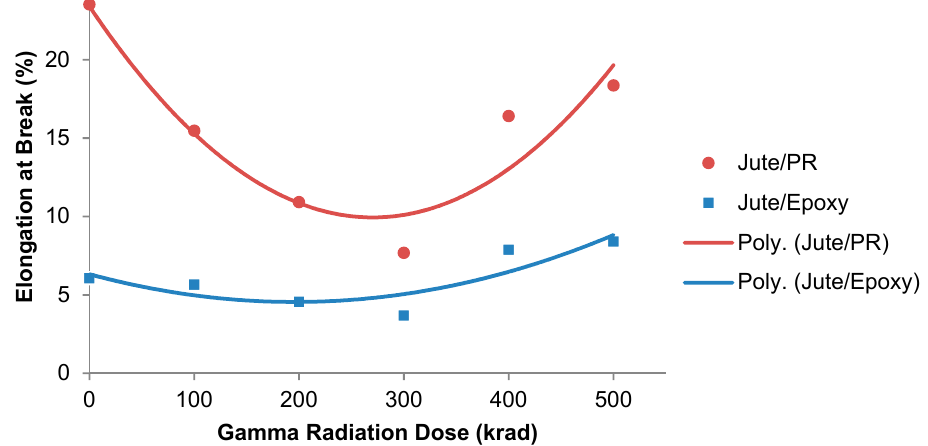
Figure 4. Gamma radiation effects on the elongation at break % (Eb%) of the Jute/PR and Jute/Epoxy composites.